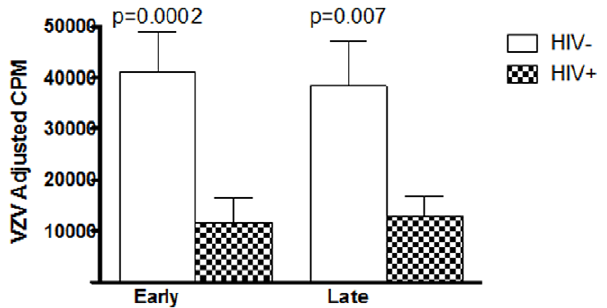
Figure 2. Cell-mediated immunity in HIV-infected and unin- fected pregnant women during early and late gestation. Data were generated using VZV- and mock-stimulated cryopreserved PBMC. Bars represent means and SEM of adjusted VZV-specific counts-per- minute (cpm) after subtraction of mock-stimulated cpm. Significant differences between HIV-infected and uninfected women at each time point are indicated by the p values on the graph (unpaired T test using log-transformed data).